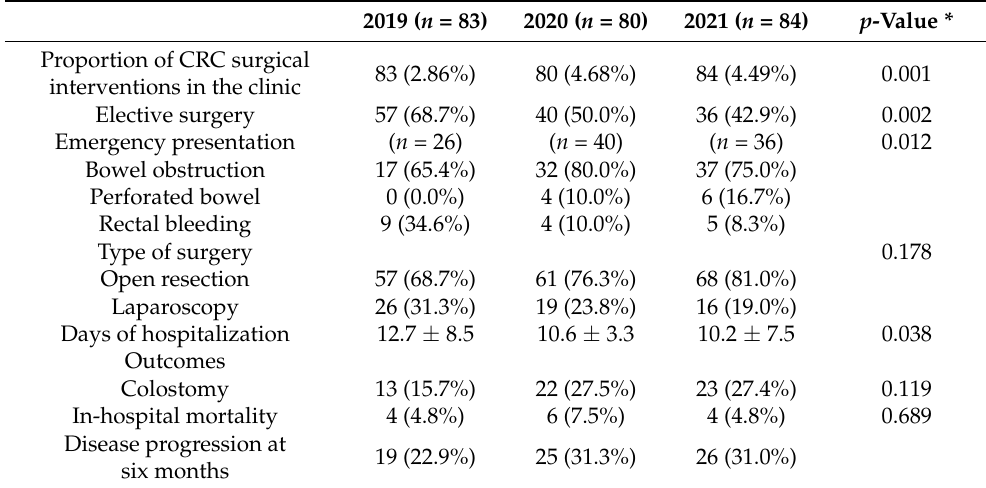
Table 3. Comparison of colorectal cancer surgery during the study